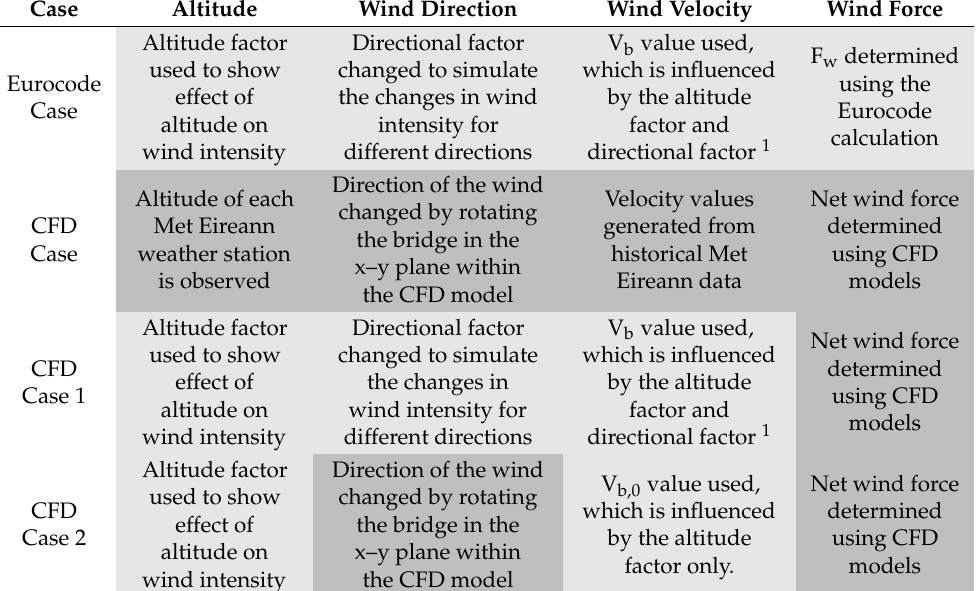
Table 2. Differences between individual cases: Eurocode Case, CFD Case 1, CFD Case 2 and CFD Case 3, in terms of the factors that influence the wind force values, and the method by which these factors are determined.